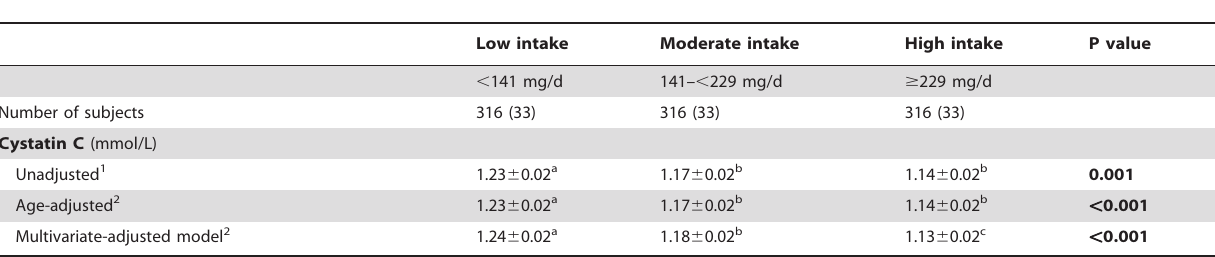
Table 2. Baseline cystatin C concentration according to groups of proanthocyanidin